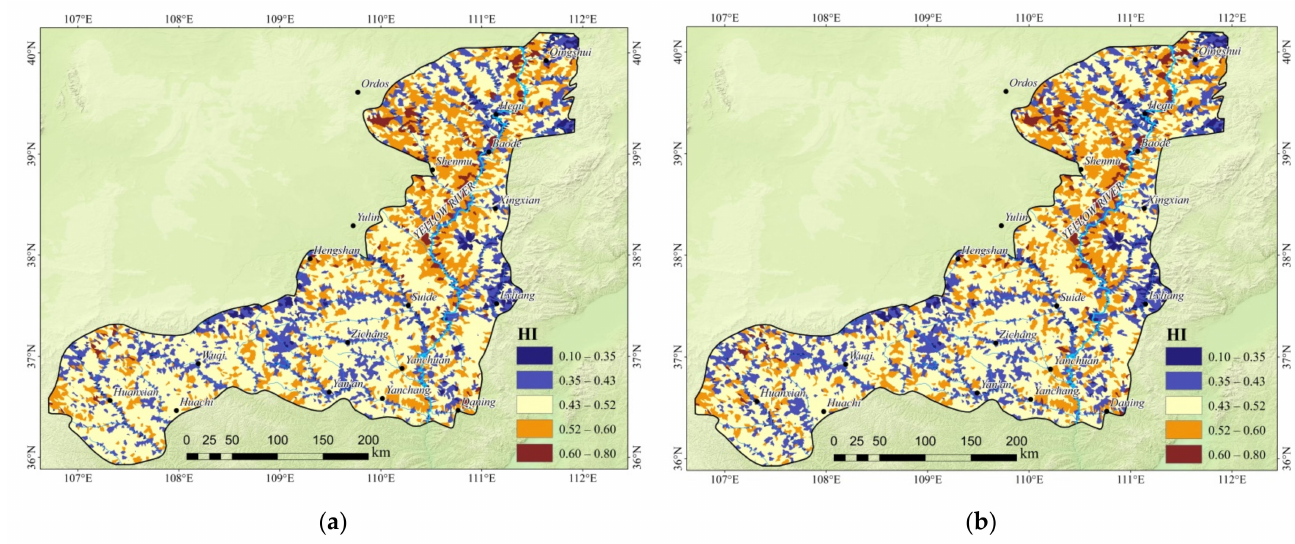
Figure 6. The spatial distribution map of HI value: ( a ) modern terrain; ( b ) underlying terrain. Table 1. The area ratio of underlying and modern terrains in different development stages. Hypsometric